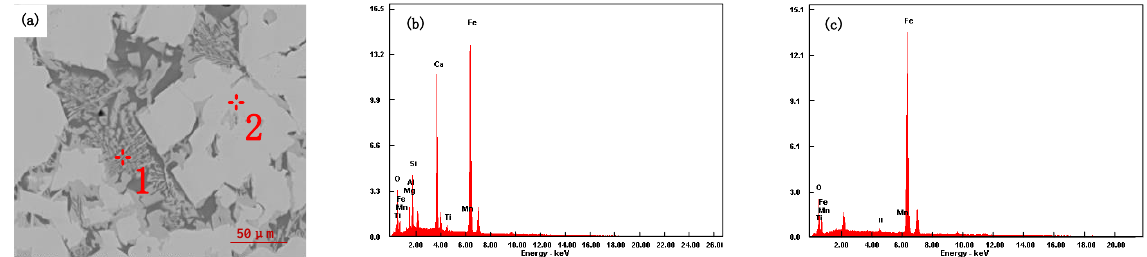
Figure 13. Scheme 1 SEM and EDS diagram of sinter: ( a ) Scheme 1 sinter, ( b ) 1, ( c ) 2.